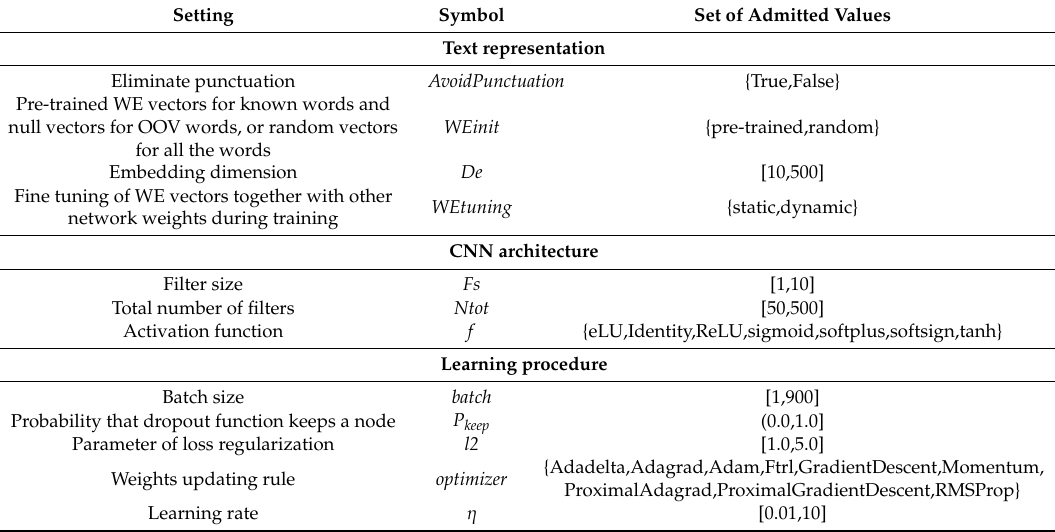
Table 3. Freely adjustable settings of the Question Classification (QC) model analyzed here and their admitted